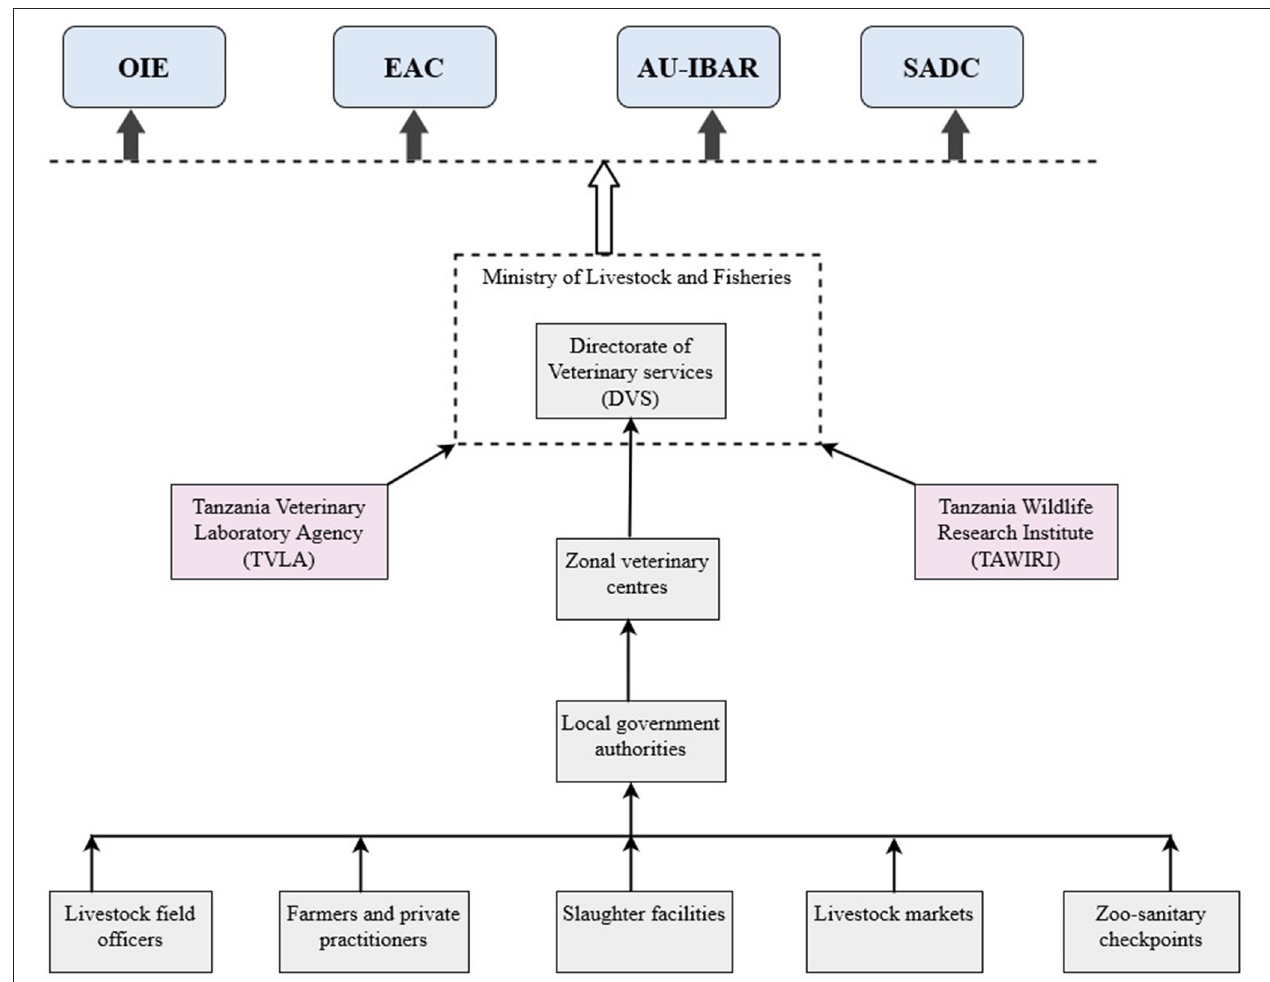
FIGURE 1 | Tanzania’s animal health surveillance reporting